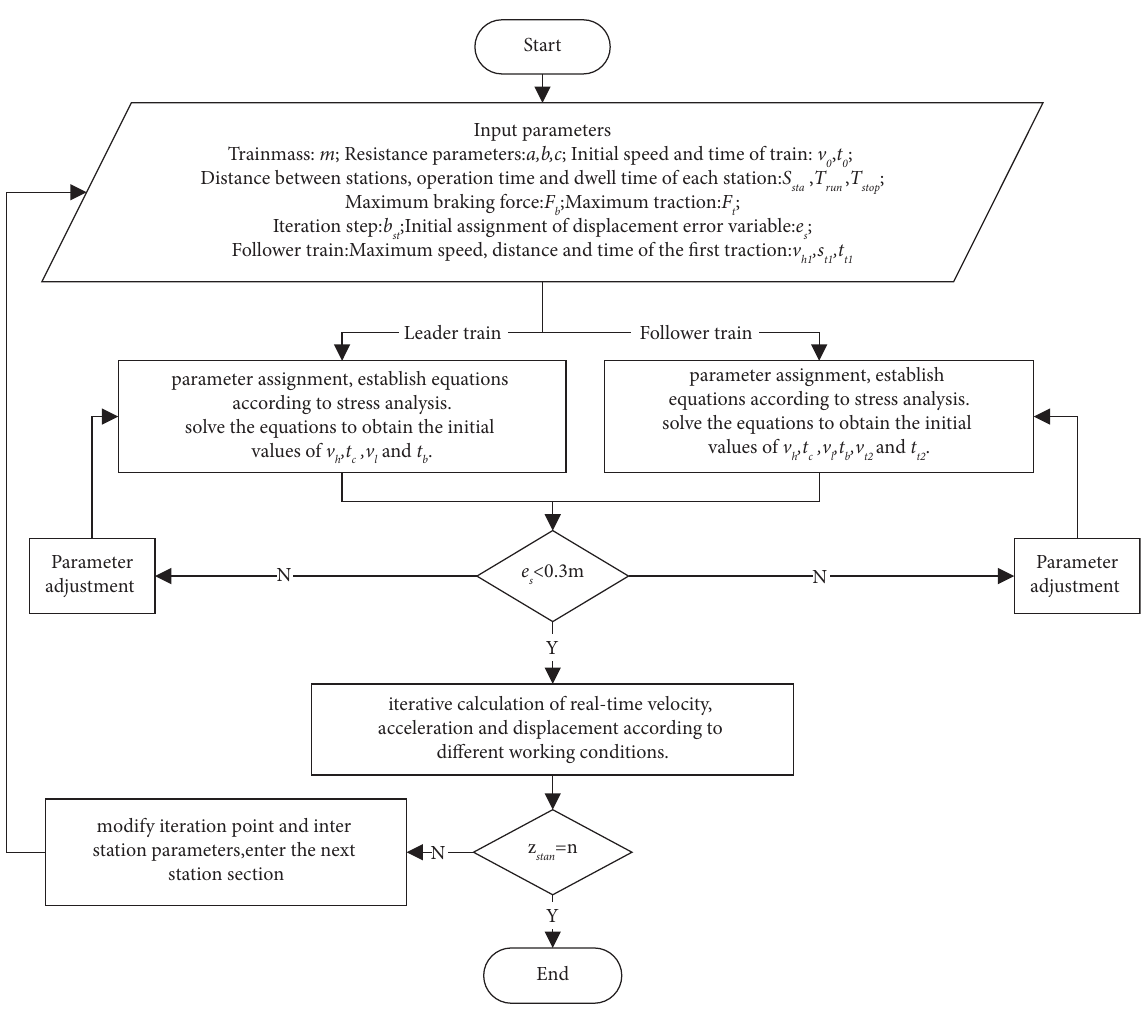
Figure 2: Parameter setting and solution